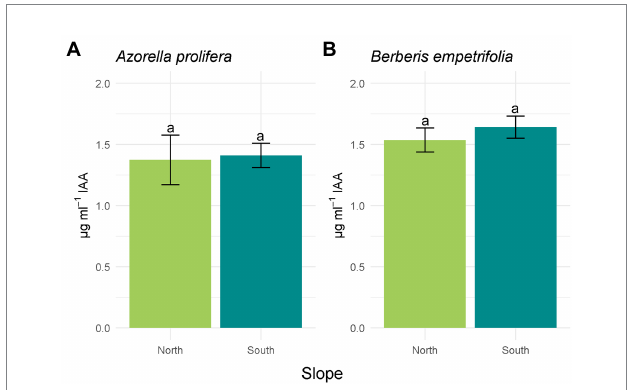
FIGURE 4 Indoleacetic acid (IAA) production of bacteria isolated from 2 species of Andean xerophytic formations on contrasting slopes: Azorella prolifera (A) and Berberis empetrifolia (B) . For each species, north slope is shown in green and south slope in light blue. Values indicate average ±SE. Equal letters indicate no differences ( p >